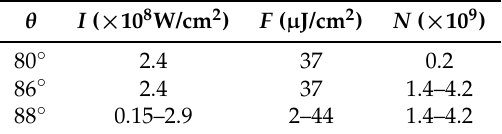
Table 3. Far-field laser irradiation parameters for gold film on mica (15 nm thick) and on glass (30 nm thick): angle of incidence θ , laser peak intensity I , pulse fluence F , number of pulses N